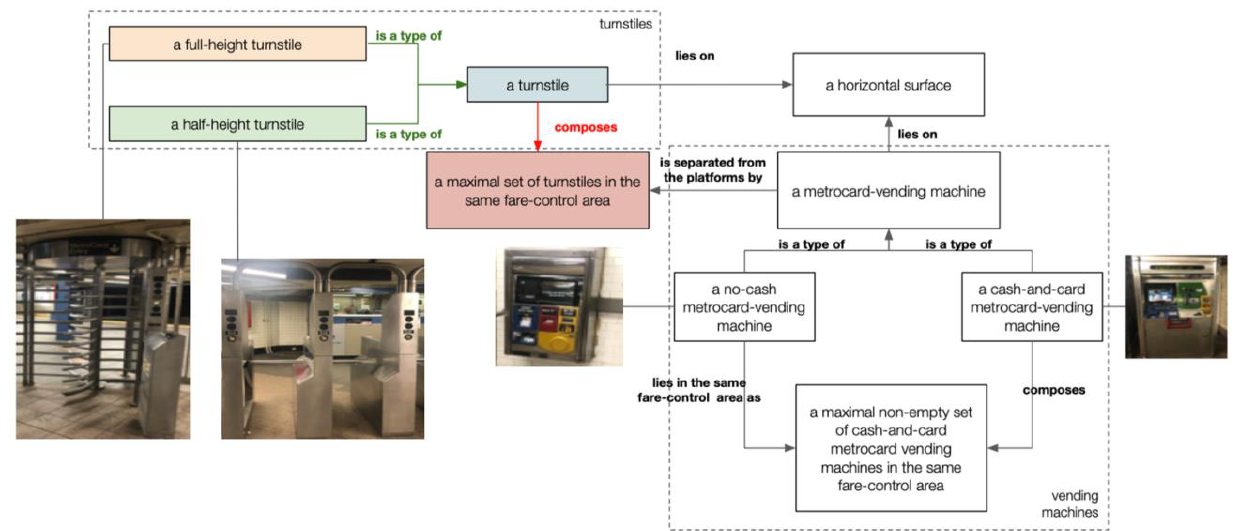
Figure 2. Olog representing multiple types of turnstiles and vending machines on the 14th St-Union Square station, where each solid box is an entity and each arrow is an aspect. The flattening of the structure allows for the distinction between different kinds of metrocard-vending machines and turnstiles, while noting the relationships between these entities and their commonalities (via associativity). The use of quantifiers and determiners (maximal, non-empty) allows the transformation of one-to-many relationships into functional relationships. The colors refer to the further information provided in Fig. 3.